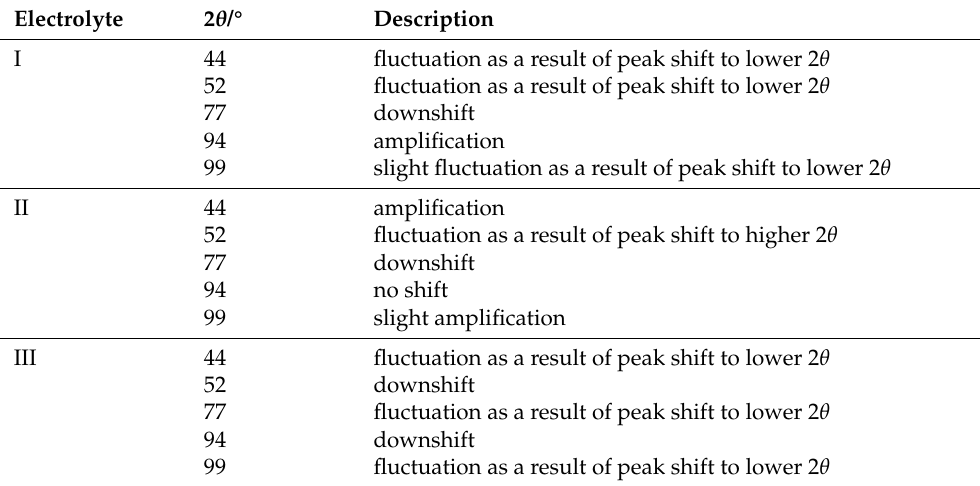
Table 4. Characteristic features of the substrate-related Al peaks within the XRD intensity difference curves in Figures 4, 7 and